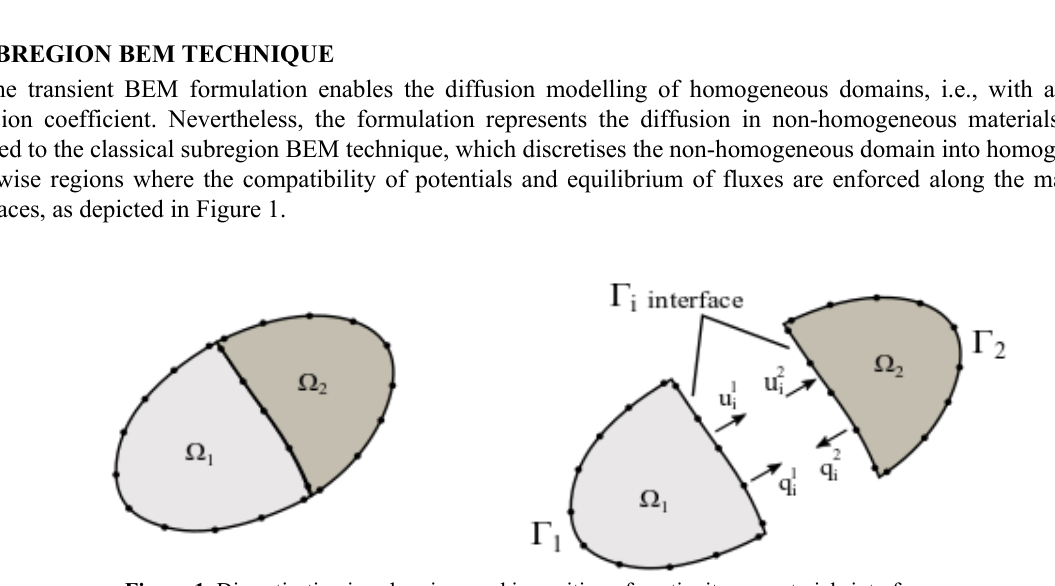
Figure 1. Discretisation in subregions and imposition of continuity on materials